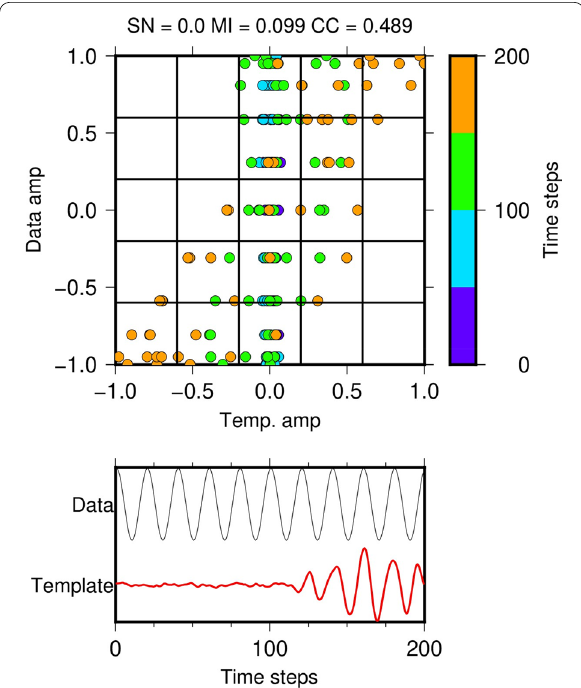
Fig. 7 Scatter plot showing the correspondence between the sinusoidal wave noise and the template waveform, using the data from 12 s before Figs. 5 and 6. These plots correspond to the SN case in Fig. 6c